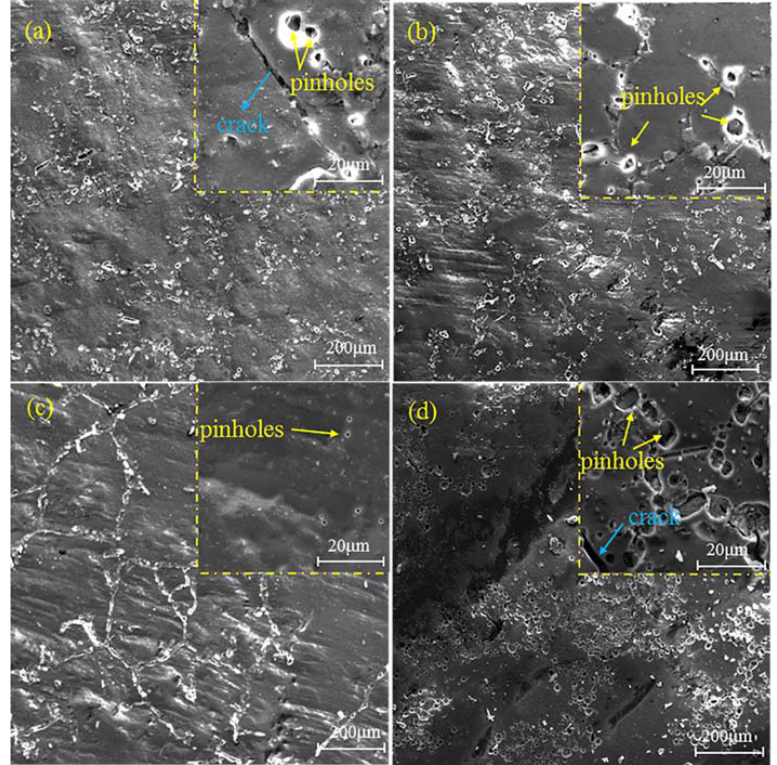
Figure 3. SEM images of different nano ‐ ZrO 2 ‐ modified coatings after 192 h of acid immersion: Z ‐ 0 coating ( a ), Z ‐ 1 coating ( b ), Z ‐ 3 coating ( c ), and Z ‐ 5 coating ( d ).